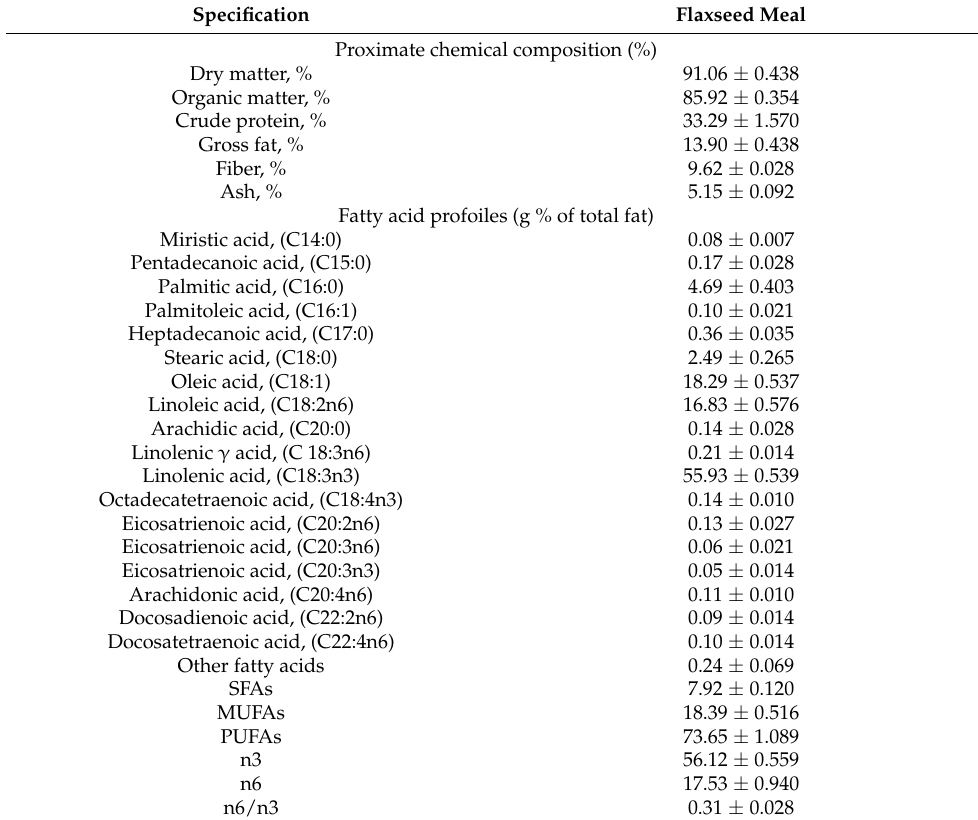
Table 2. Nutrient contents of the flaxseed meal.